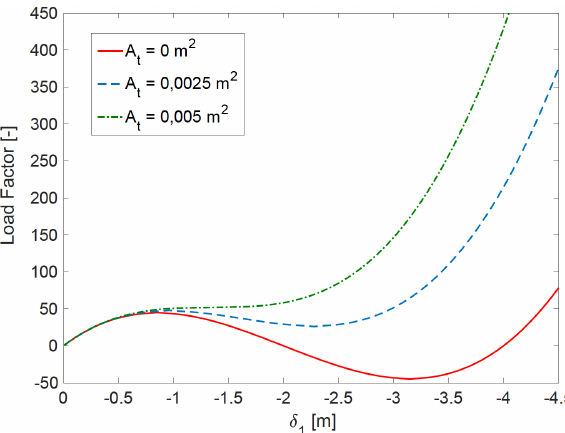
Table 3: Sixteen-member lattice structure